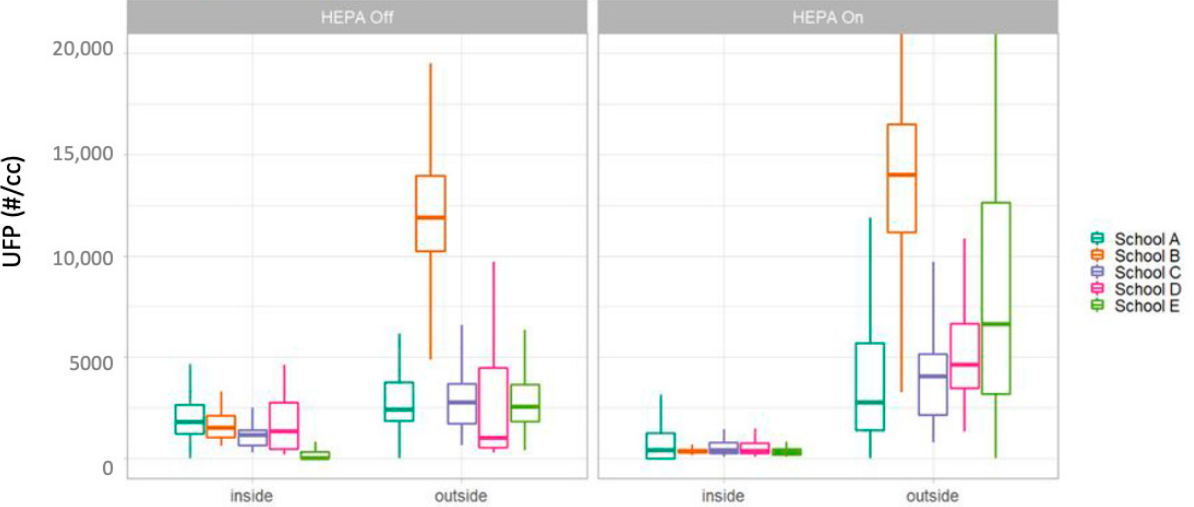
Figure 7. Distribution of UFPs before and after HEPA filter deployment at all five school locations. In the boxplots, the upper whisker represents the maximum; the top of the box represents the 75th percentile; the middle line represents the median or 50th percentile; the bottom of the box presents the 25th percentile; and the lower whisker represents the minimum.